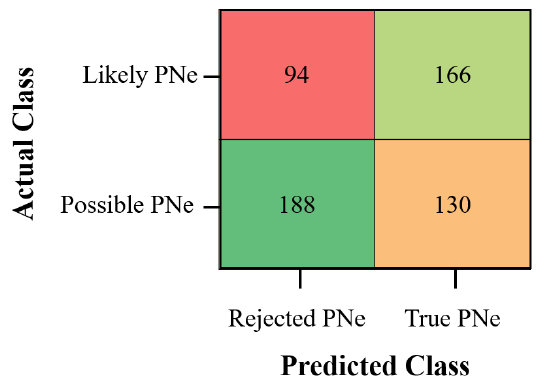
Figure 10. The confusion matrix of combined DenseNet201 DTL models predictions for Possible and Likely